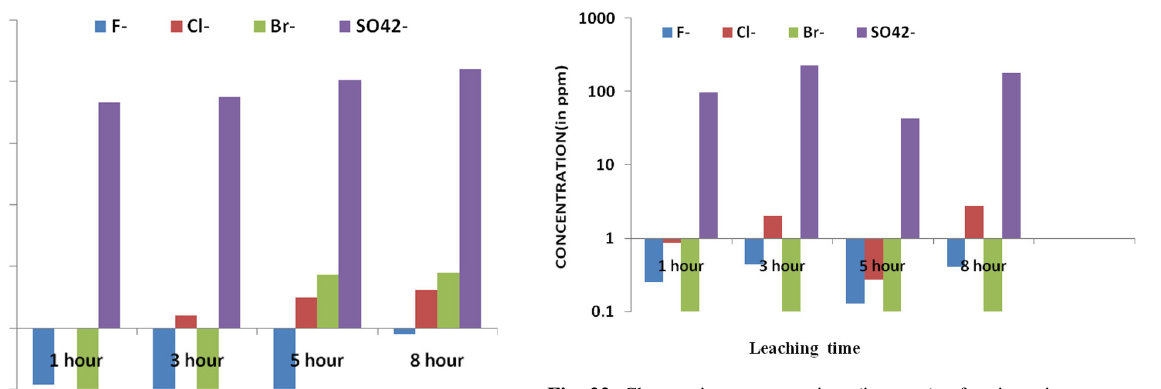
Fig. 22 Change in concentration (in ppm) of anions in aqueous leachates of Ledo OB (LOB-15B) with leaching time (in hour) at 65 (cid:3) C